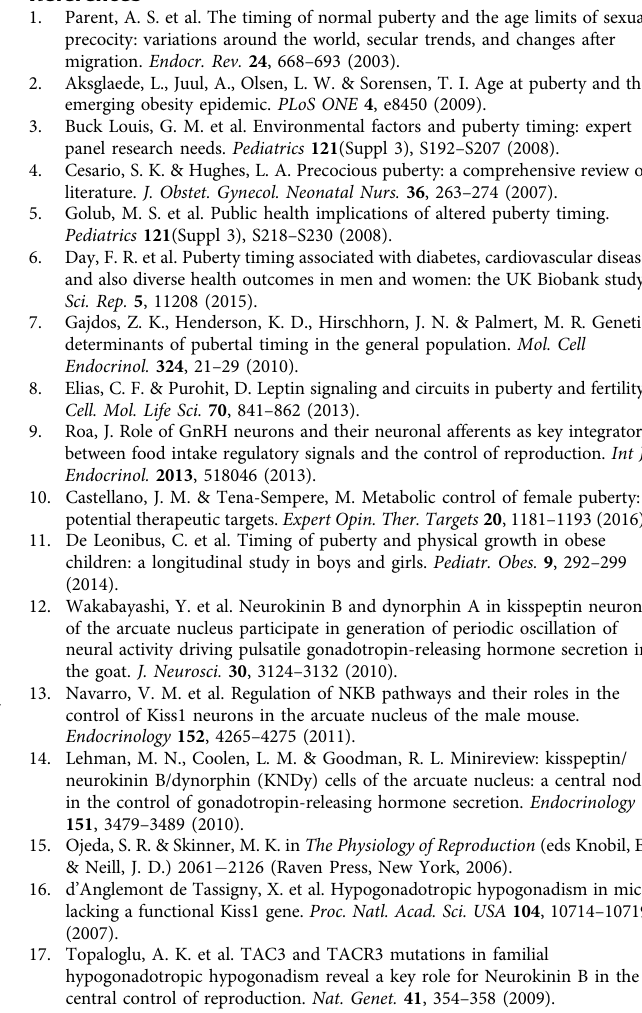
Supplementary Table 2. The PCR was performed using 2 − 3 μ l of cDNA template from each RT reaction in a 30 μ l PCR mix as follows: initial denaturation for 2 min at 94 °C; 20 s at 94 °C, 30 s at 61 °C ( Sirt1 ) or 57°C ( Kiss1 ), 30 s at 72 °C for 50 cycles of ampli fi cation, with a fi nal extension of 5min at 72 °C. PCR products were sequenced to con fi rm their